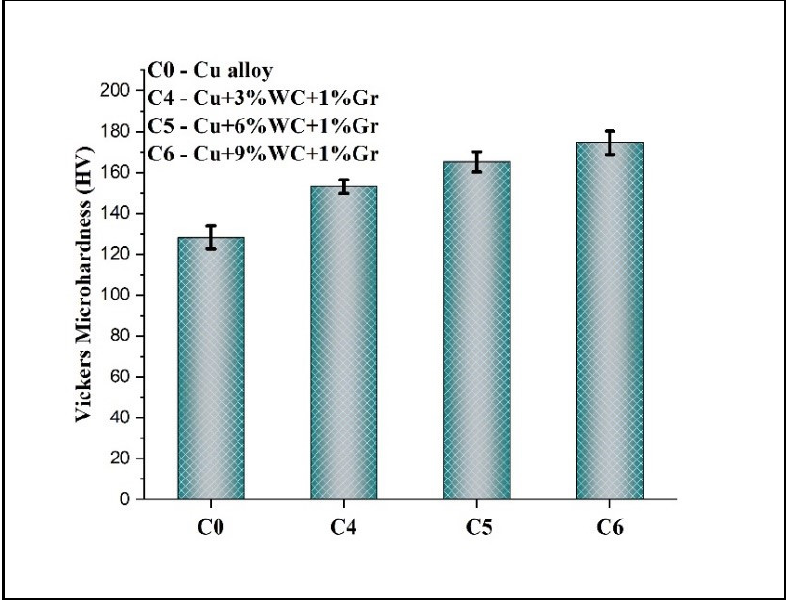
Figure 10. Variation of Vickers micro-hardness Cu alloy and Cu-(3, 6, 9) wt.% WC-Gr hybrid composites.